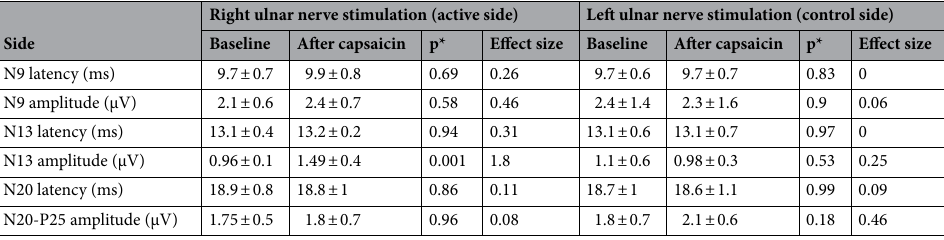
Table 1. Experiment 1: Capsaicin induced modulation of somatosensory evoked potential components. Data are expressed as mean ± SD. Effect size are expressed as Cohen’s d. *p values of post hoc Sidak’s multiple comparisons test (Two-way Repeated Measures